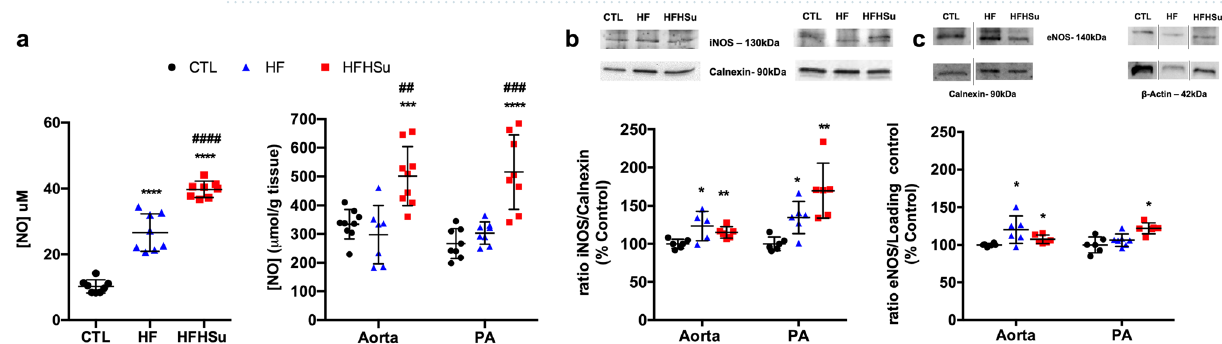
Figure 4. Effect of type 2 diabetes progression on systemic and local nitric oxide levels and on the expression of eNOS and iNOS. Nitric oxide levels on plasma ( a , left panel) and on aorta and pulmonary artery ( a , right panel); Average expression of ( b ) iNOS (130 kDa) and ( c ) eNOS (140 kDa), and the loading proteins, calnexin (90 kDa) and β-Actin (43 kDa) in the aorta and PA of control (n = 6), HF (n = 5–6) and HFHSu (n = 6) animals. Representative western blots for each protein studied are depicted above the respective graphs. For eNOS expression, the representative bands were cropped due to the sample order in the membrane. For complete membrane image see Supplementary data. Values are presented as scatter plots ± SD; One-way ANOVA with Dunnet’s comparison test. * p < 0.05, ** p < 0.01, *** p < 0.001 and **** p < 0.0001 versus control animals; ## p < 0.01, ### p < 0.001 and #### p < 0.0001 comparing the groups submitted to the hypercaloric animals to different hypercaloric diets during different times of exposure, on the levels of NO in the plasma and in aorta and PA, and on the expression of eNOS and iNOS in both arteries. Both hypercaloric diets increased NO plasma levels, with the HF diet promoting a significant increase of 160.3% and HFHSu inducing an even higher increase of 289% in the NO plasma levels in relation to controls (NO plasma levels in control animals of 10.2 ± 2.0 μM) (Fig. 4a left panel). When the NO levels were measured in both arteries, 3 weeks of exposure to HF diet were insufficient to promote significant alterations in the NO levels. However, HFHSu diet for 25 weeks increased NO levels by 50% in the aorta and by 93% in the PA when